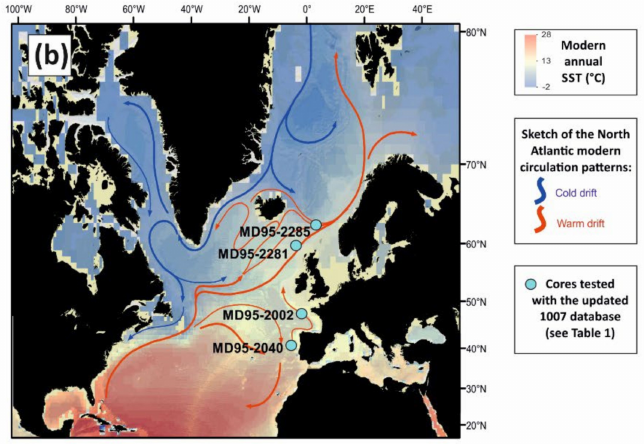
Figure 1. ( a ) Map of the 1007 database plotted on a physiographic basis (elevation) with the distinction of key hydrographical provinces (modified from Eynaud et al., 2018 [17]). ( b ) Location of the cores of interest with regard to the modern SST (annual mean) distribution and circulation patterns (redrawn from Mary et al. 2017